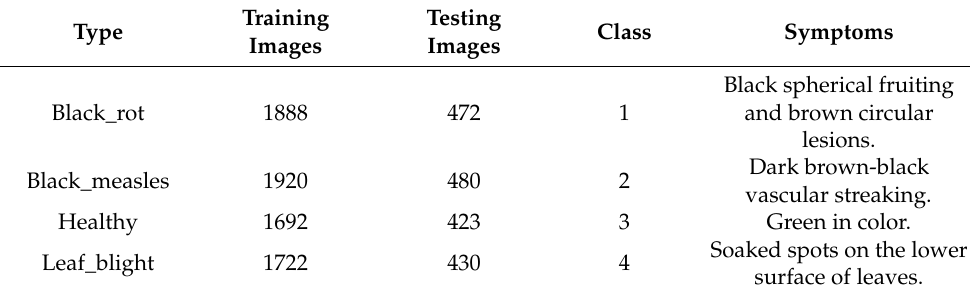
Table 2. Description of Training, Testing Data with symptoms.